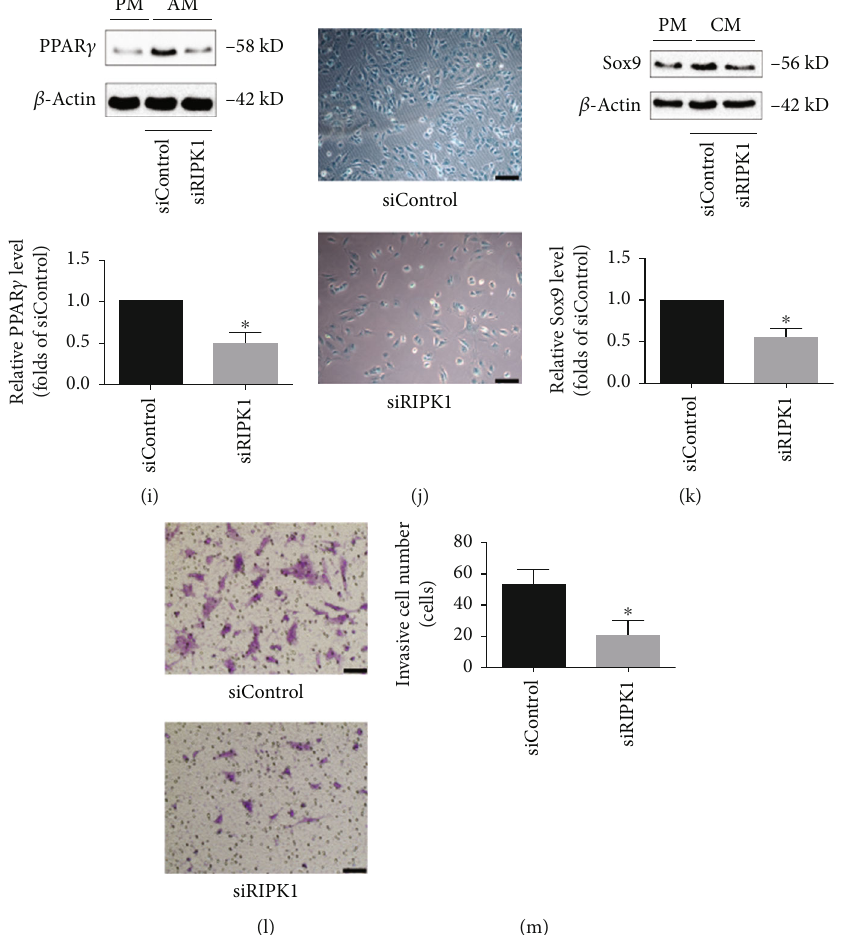
Figure 1: Biological function of RIPK1 on proliferation, di ff erentiation, and migration of bone marrow MSCs. (a) The bone marrow MSCs were transfected with siControl or siRIPK1 for 24h; then, knockdown e ffi ciency of RIPK1 was assessed by western blotting. Representative western blots of the expression of RIPK1. Histogram analysis showing the relative protein levels of RIPK1. Data are presented as the means ± SD from three independent experiments ( ∗ p < 0 : 05 , vs. siControl; n = 3 ). siRIPK1(#1) showed the highest e ffi ciency among three siRIPK1. (b) Morphologic changes in bone marrow MSCs after 72h of siRNA transfection. In the siRIPK1 group, more cells detached from culture plates with a morphology transition ( scalebar = 100 μ m). (c) Proliferation of bone marrow MSCs was estimated by CCK-8 assay at 24, 48, and 72 h after transfection with siRNA. Knockdown of RIPK1 resulted in inhibition of cell proliferation, compared with the control group. Values are expressed as the means ± SD from three independent experiments ( ∗ p < 0 : 05, vs. siControl; n = 5 ). (d) Quanti fi cation of EDU-positive cells in two groups, showing that knockdown of RIPK1 led to decrease of EDU incorporation. Values are expressed as the means ± SD from three independent experiments ( ∗ p < 0 : 05 , vs. siControl; n = 3 ). (e) Representative images of EDU incorporation in bone marrow MSCs, and nuclei were stained with Hoechst ( scale bar = 100 μ m). (f, g) E ff ect of RIPK1 on osteogenic di ff erentiation in bone marrow MSCs. The Alizarin Red staining of bone marrow MSCs after incubation with osteogenic medium for 14d ( scalebar = 200 μ m) (f). Representative western blots of the expression of Runx2. Histogram analysis showing the relative protein levels of Runx2. Data are presented as the means ± SD from three independent experiments ( ∗ p < 0 : 05 , vs. siControl; n = 3 ) (PM: proliferative medium; OM: osteogenic medium) (g). (h, i) E ff ect of RIPK1 on adipogenic di ff erentiation in bone marrow MSCs. The Oil Red O staining of bone marrow MSCs after incubation with adipogenic medium for 14d ( scale bar = 100 μ m) (h). Representative western blots of the expression of PPAR γ . Quantitative data showing the relative protein levels of PPAR γ . Data are presented as the means ± SD from three independent experiments ( ∗ p < 0 : 05 , vs. siControl; n = 3 ) (PM: proliferative medium; AM: adipogenic medium) (i). (j, k) E ff ect of RIPK1 on chondrogenic di ff erentiation in bone marrow MSCs. The Alcian Blue staining of bone marrow MSCs after incubation with chondrogenic medium for 14d ( scale bar = 100 μ m) (j). Representative western blots of the expression of Sox9. Quantitative data showing the relative protein levels of Sox9. Data are presented as the means ± SD from three independent experiments ( ∗ p < 0 : 05 , vs. siControl; n = 3 ) (PM: proliferative medium; CM: chondrogenic medium) (k). (l, m) E ff ect of RIPK1 on migration of bone marrow MSCs. Transwell invasion assay (l) and quantitative data (m) showed signi fi cant decrease of invasive cells in siRIPK1 group. Values are expressed as the means ± SD from three independent experiments ( ∗ p < 0 : 05 , vs. siControl; n = 3